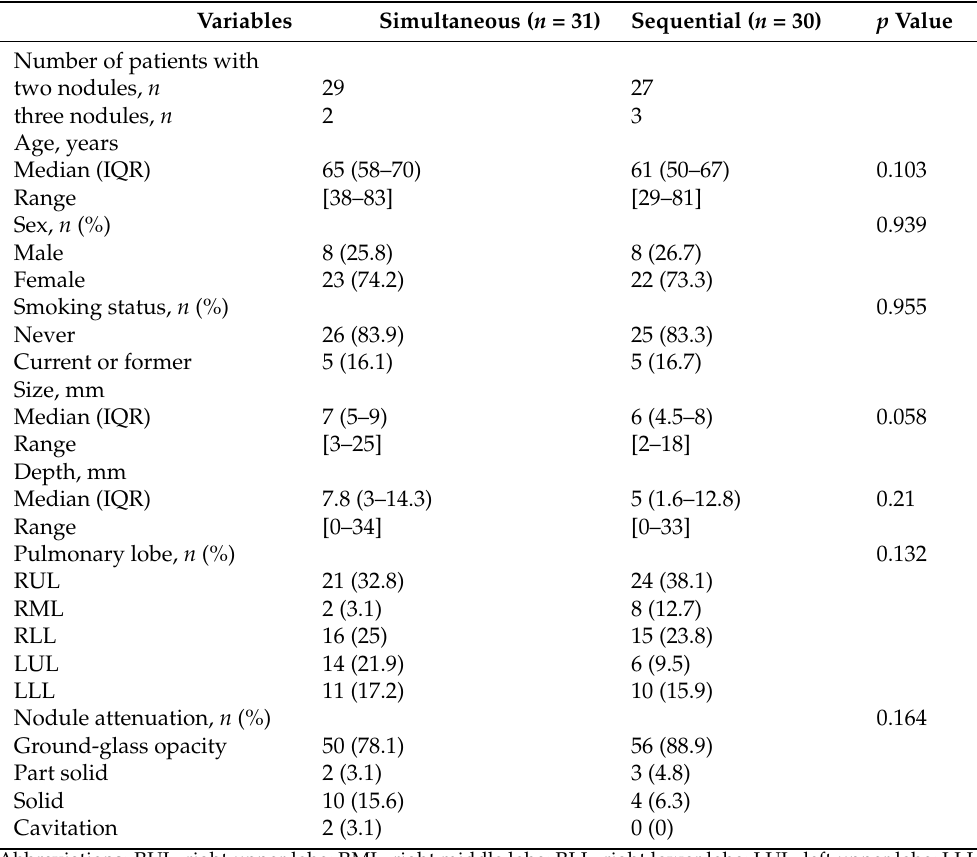
Table 1. Nodule and patient